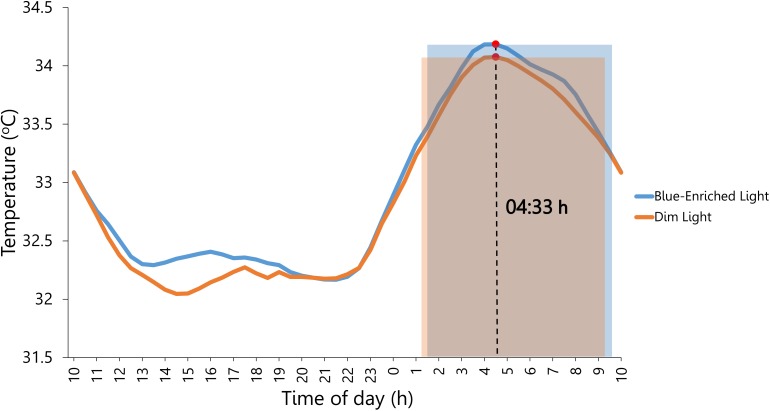
Circadian rhythm of wrist temperature averaged across participants prior to lighting exposure during the 4 days of the experiment. Blue and orange shaded rectangles: sleep period in the night before the exposure to blue-enriched light and dim light, respectively. Marked by a red circle (∙) is the distal temperature maximum value (M5), which estimated the midsleep time at 4:33 am.